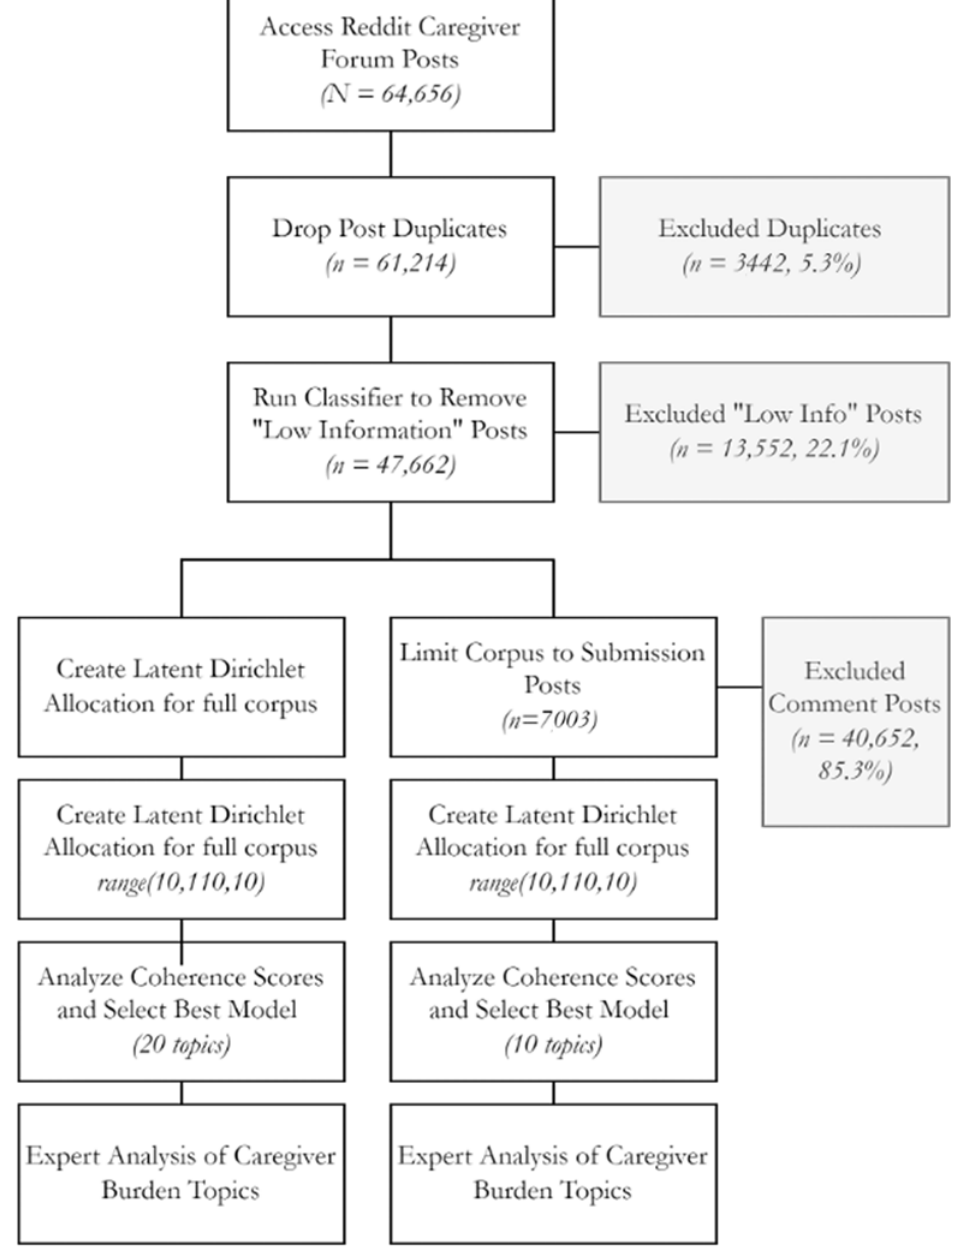
Figure 1. Methodology flowchart from accessing Reddit posts through creation of Latent Dirichlet Allocation for two corpuses (full Reddit dataset and Submissions-only dataset).